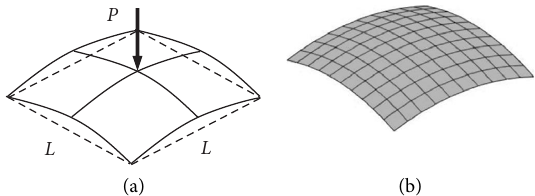
Figure 11: Shallow spherical shell model. (a) Geometric model. (b) Mesh model.